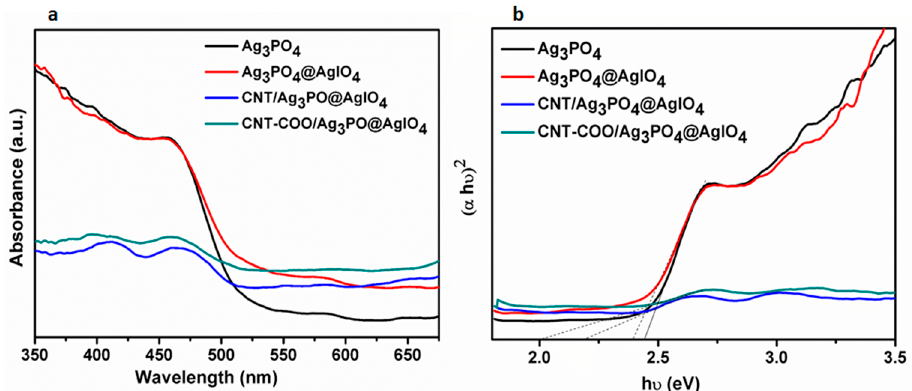
Figure 4. ( a ) DRS spectra of the synthesized materials, and ( b ) the plot of ( α h ʋ ) 2 versus energy (h ʋ ).